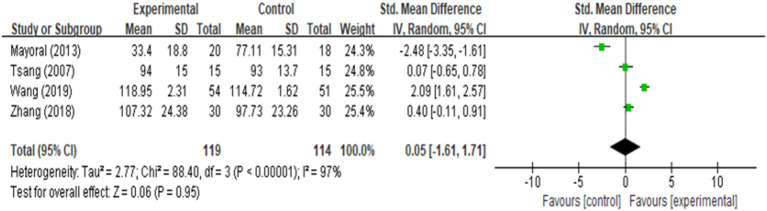
Meta-analysis and forest plot for ROM of knee.